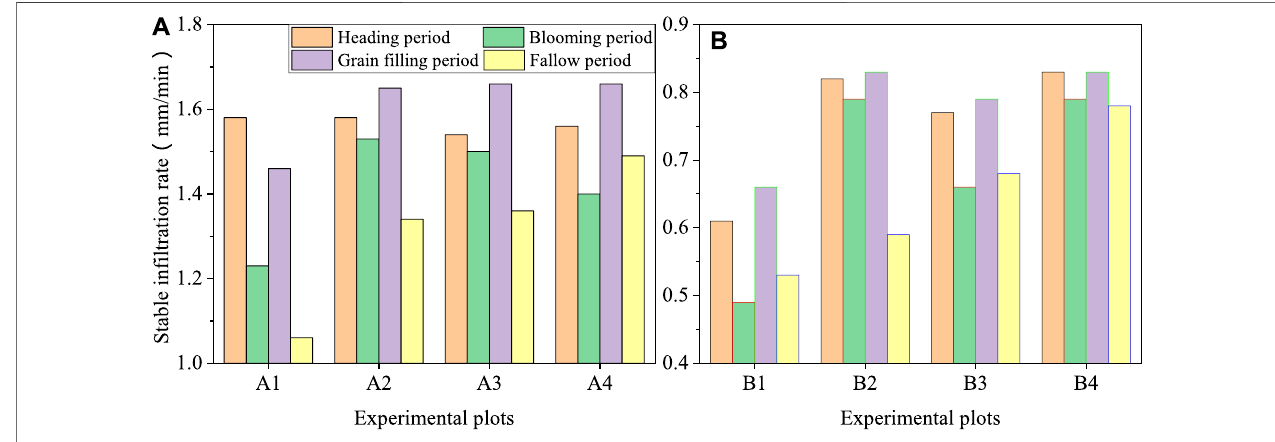
FIGURE4 | Variations in stable in fi ltrationrate in different rainfall intensity and growth periods. (A) and (B) in the picture representthe experimental plots under 100 and 50 mm/h rainfall intensity, respectively.